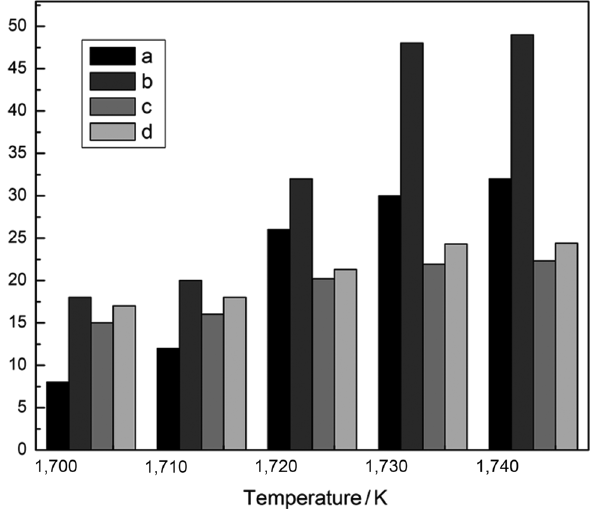
Figure 10: Precipitation amount and average grain size of rutile versus different melting